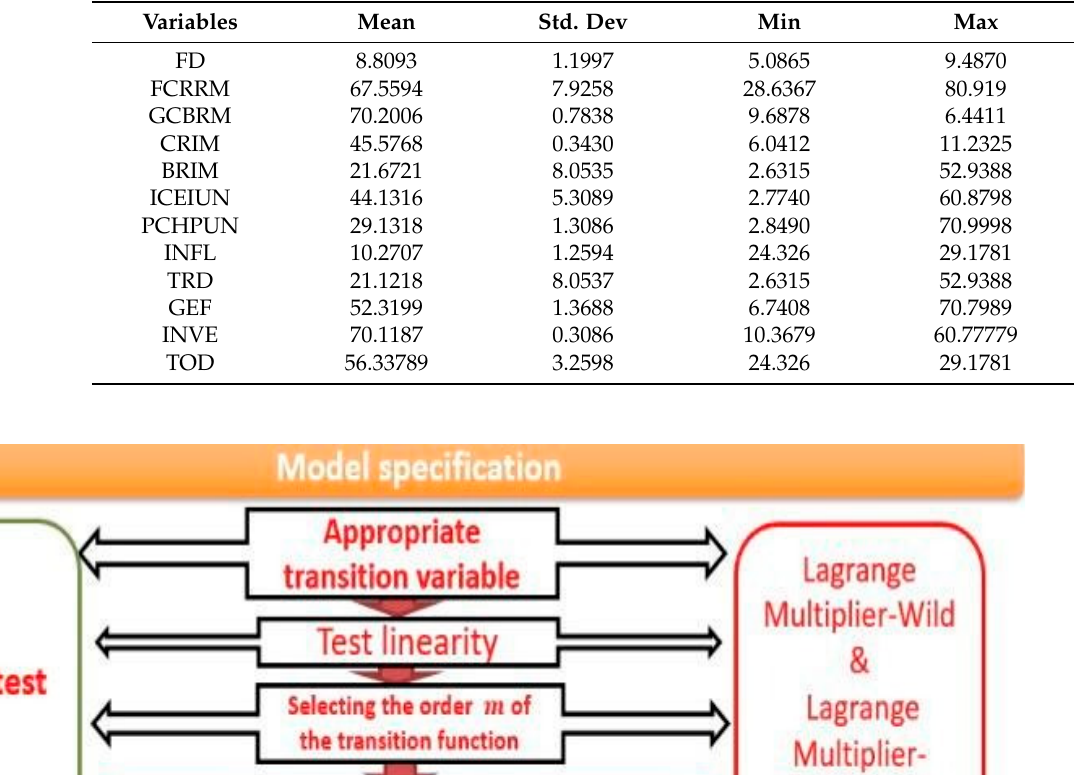
Table A1. Descriptive Statistics (Dependent and Independent Variables).